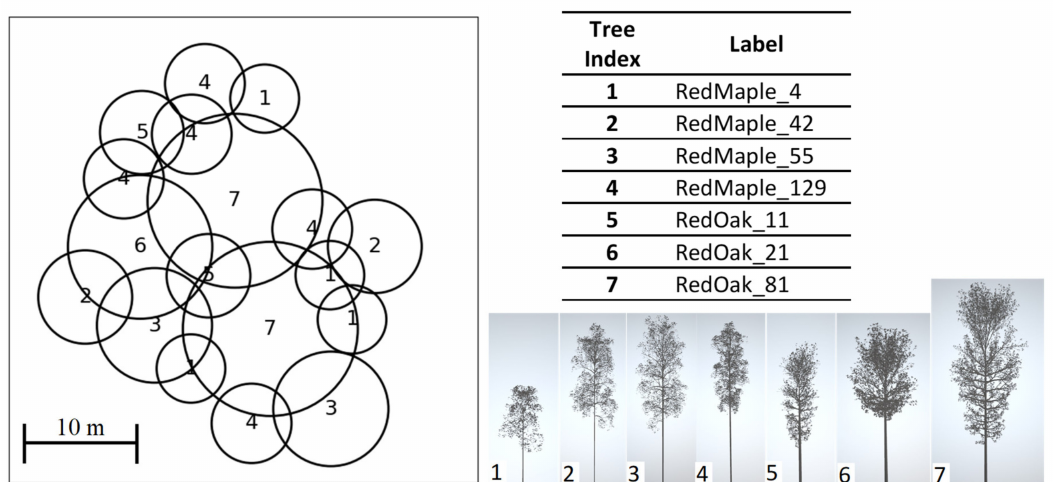
Figure 12. Diagram of the construction of the maple and oak grove. On the left side of the figure is a map with locations and footprints of the tree models in the scene. The numbers correspond the tree model index, which is listed in the table on the right side of the figure. Under the table are thumbnail views of each tree model to provide a relative approximation of the shape and size of each tree.